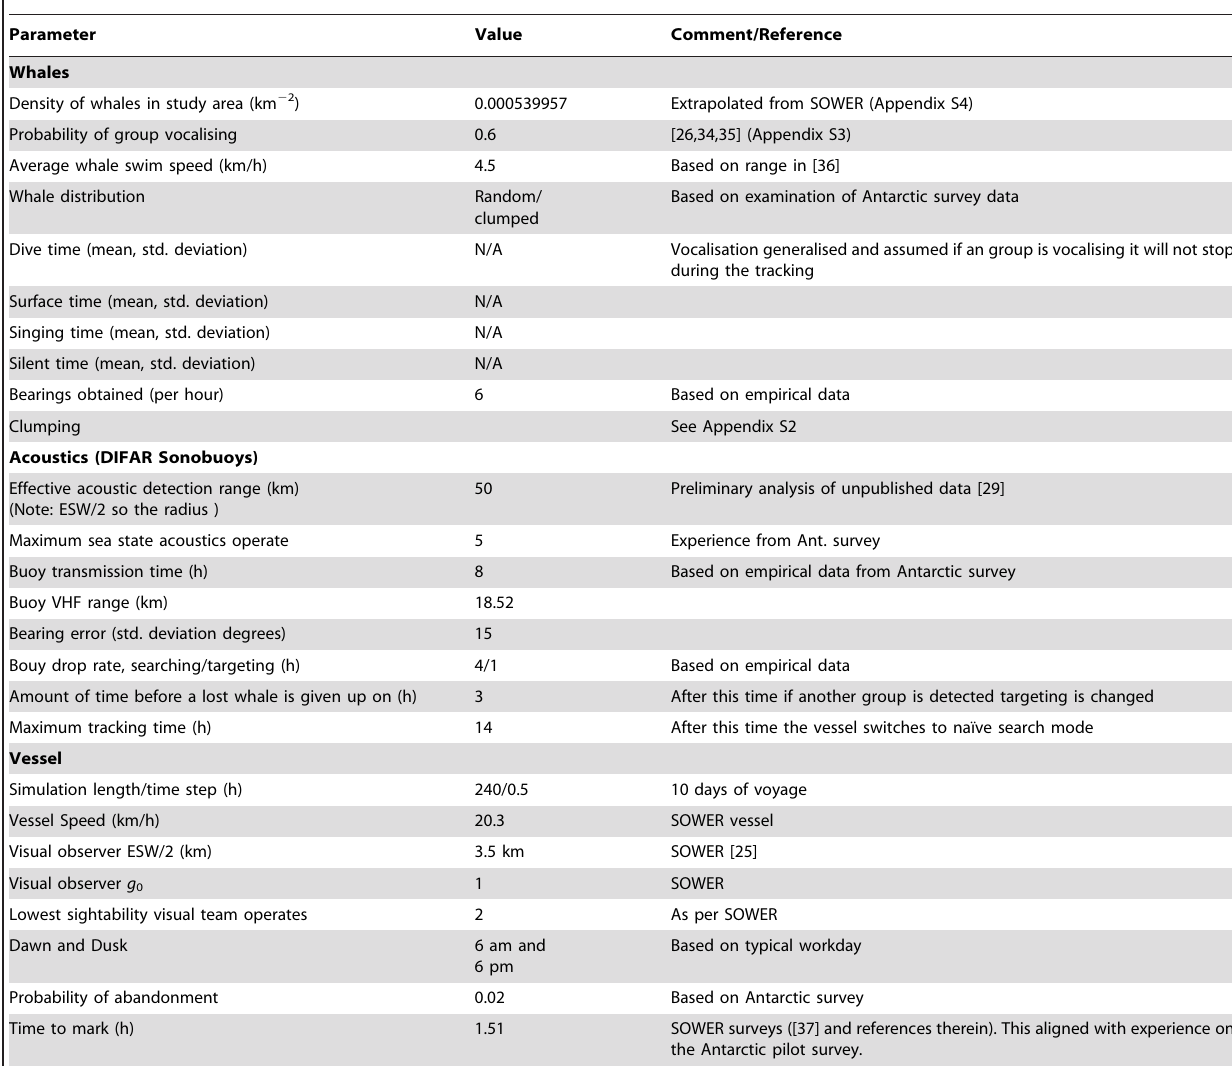
Table 2. Parameters for the simulations and sensitivity analysis of Antarctic Blue